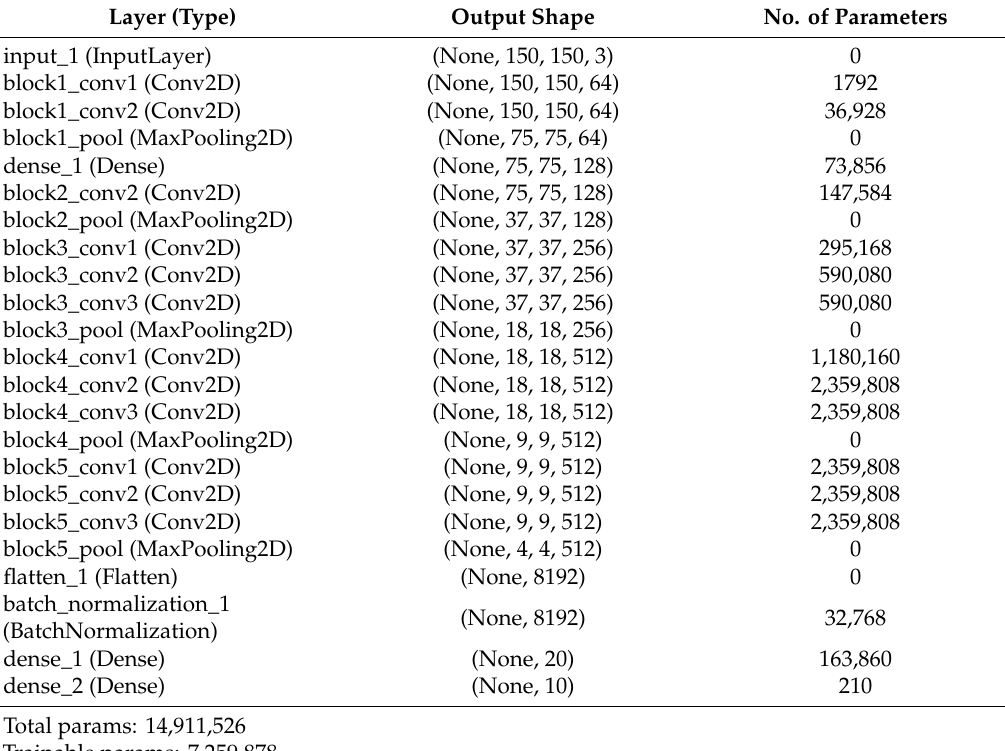
Table 1. Details of convolutional neural network used to get feature embedding for each magnetic resonance imaging (MRI) modality per